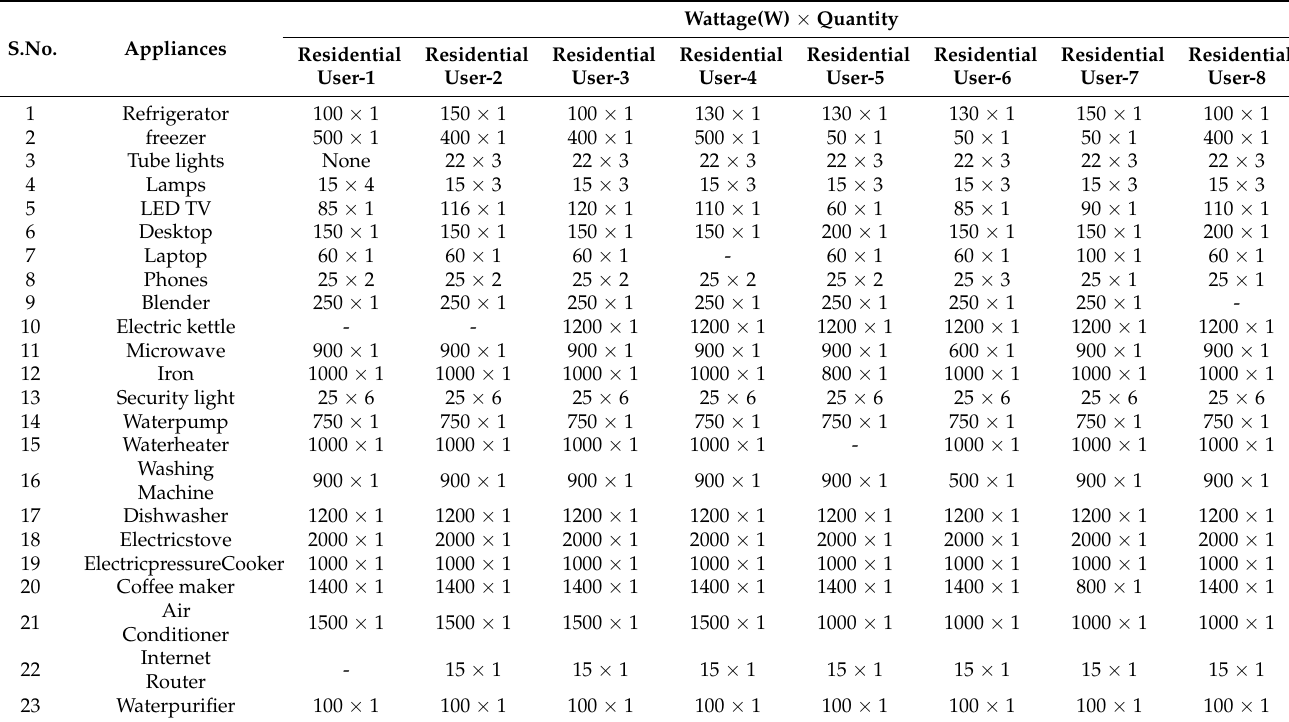
Table 2. Wattage and quantity of various appliances in the